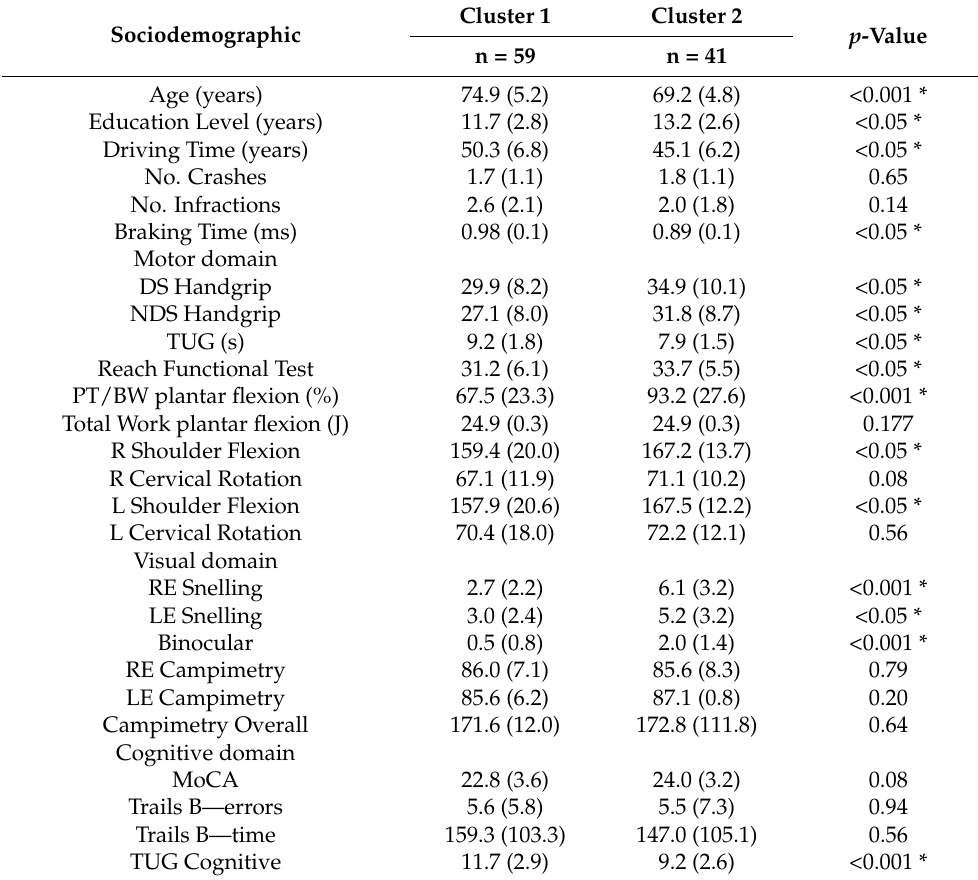
Table 2. Sociodemographic data and motor, visual, and cognitive characteristics of older drivers by